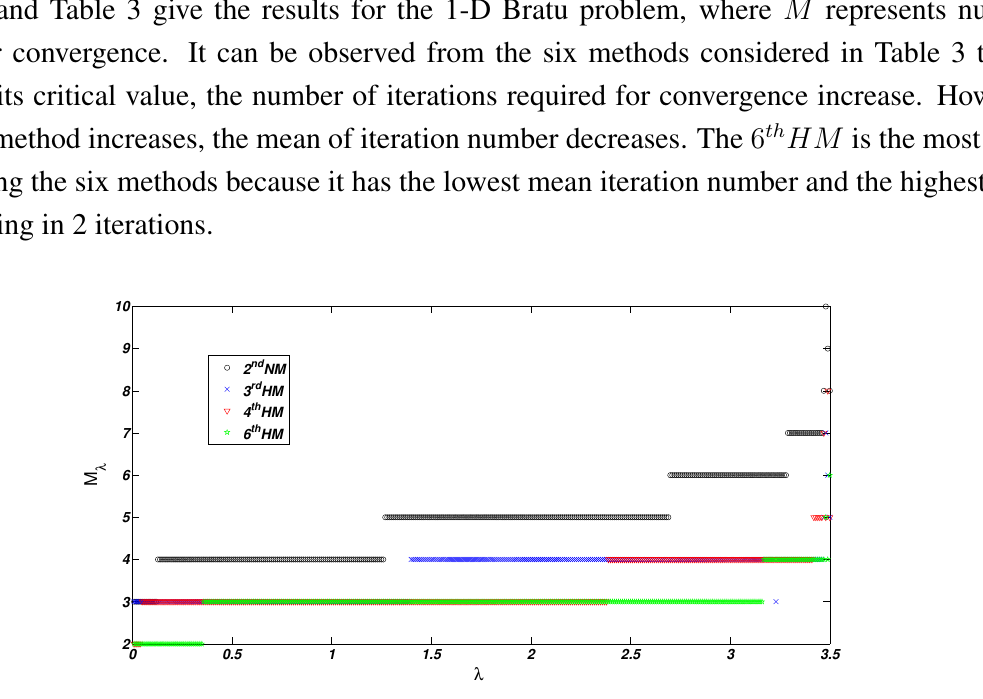
Figure 2. Variation of number of iteration with λ for the 2 nd NM , 3 rd HM , 4 th HM and 6 th HM